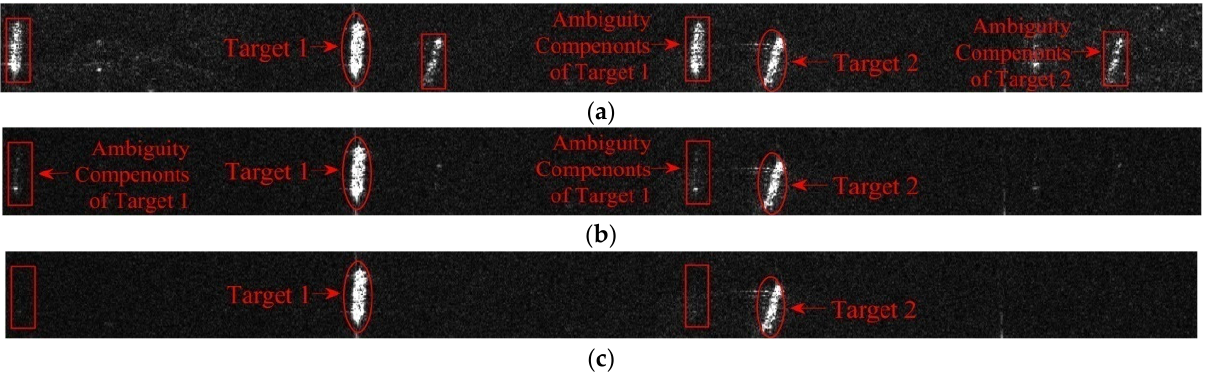
Figure 4. Multi-channel SAR image results with different calibrations (horizontal azimuth, vertical range). ( a ) Result without calibration. ( b ) Result with subspace projection calibration. ( c ) Result with the proposed calibration.